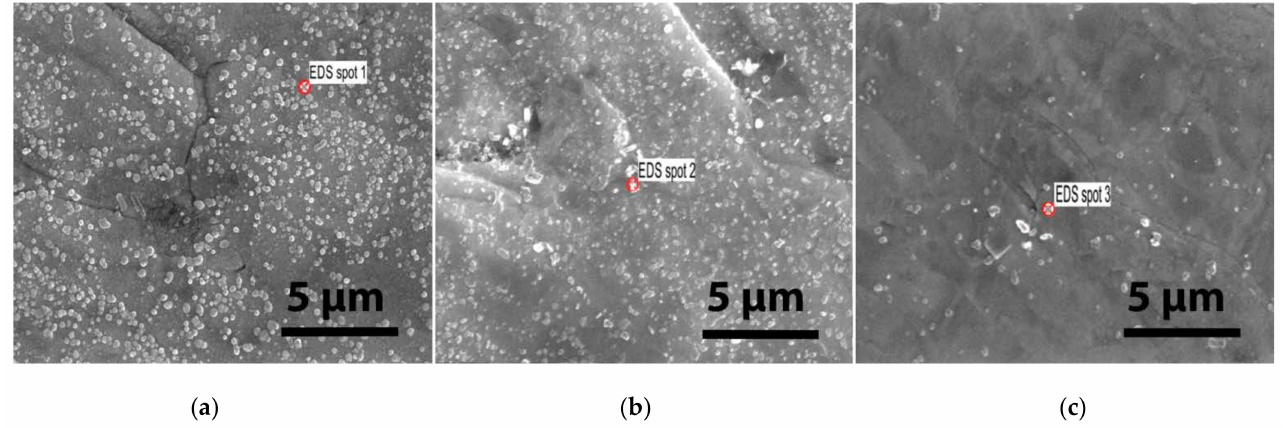
Figure 8. High-resolution SEM images of irradiated samples for a duration of 10 min in the 6 MeV EB and the droplets chosen for an EDS analysis: ( a ) pure W laminate, ( b ) (W-K) 1 laminate and ( c ) (W-K) 2 laminate.